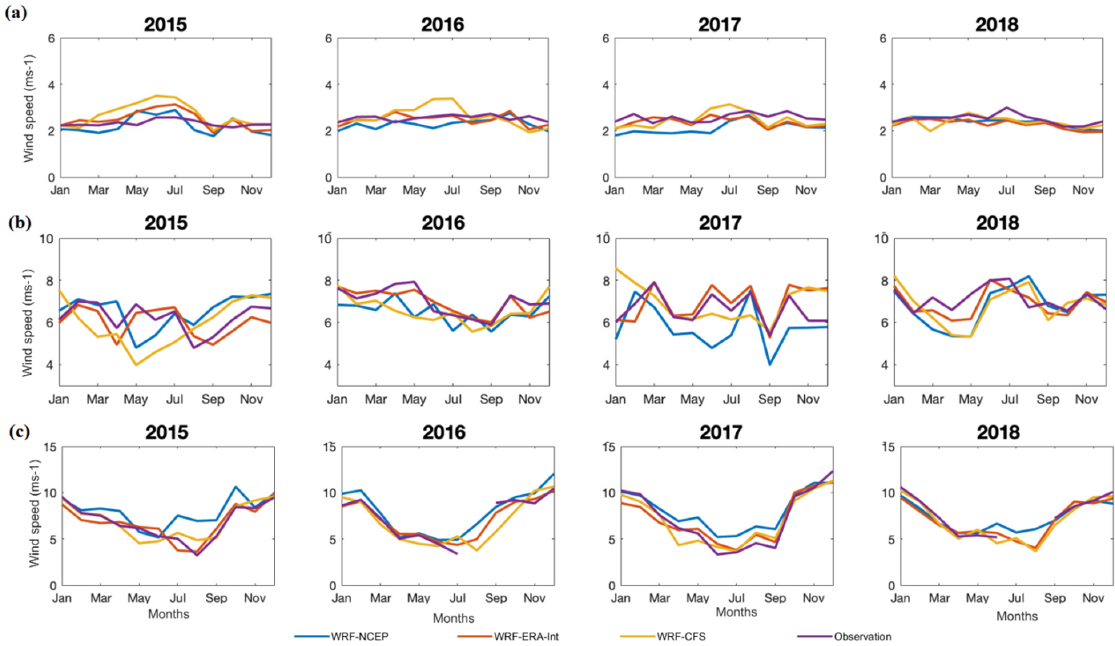
Figure 5. Monthly averaged wind speed in m s − 1 from the models and observations at the locations ( a ) Nanping, ( b ) Hong Kong, and ( c ) offshore Quanzhou. ( a ) Nanping, ( b ) Hong Kong, and ( c ) offshore